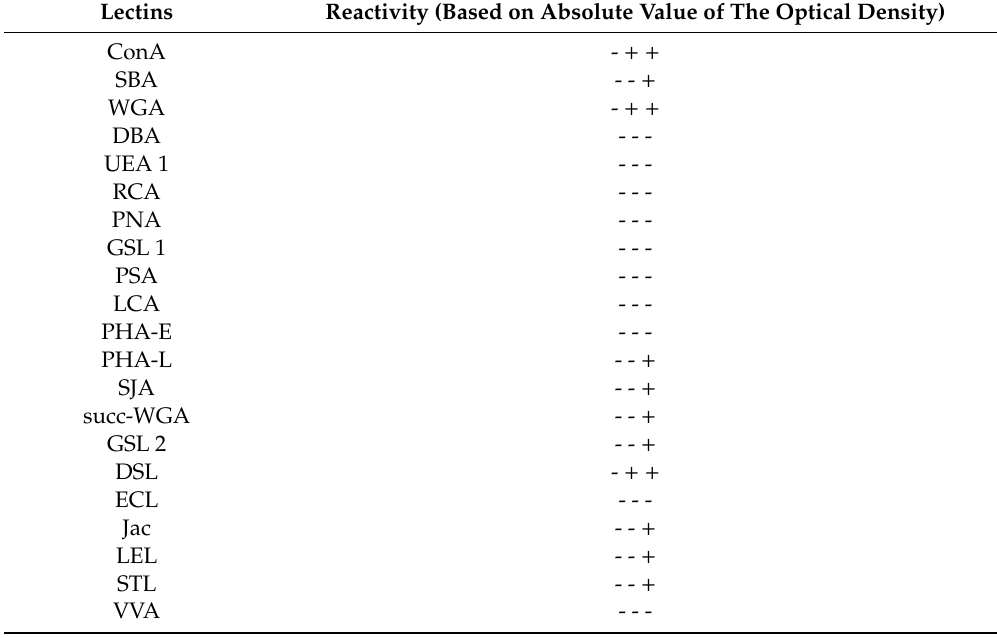
Table 4. Enzyme-Linked Lectin Assay (ELLA) test on the ASM of A. hians . The matrix was tested against 21 biotinylated lectins, expressed in absolute reactivity values of the optical density. --- = < 0.28 Optical Density (OD); -- + = 0.28 < OD < 0.33; - ++ = 0.33 < OD < 0.44. Lectins Reactivity (Based on Absolute Value of The Optical Density) ConA - + + SBA - - + WGA - + + DBA - - - UEA 1 - - - RCA - - - PNA - - - GSL 1 - - - PSA - - - - - - - -